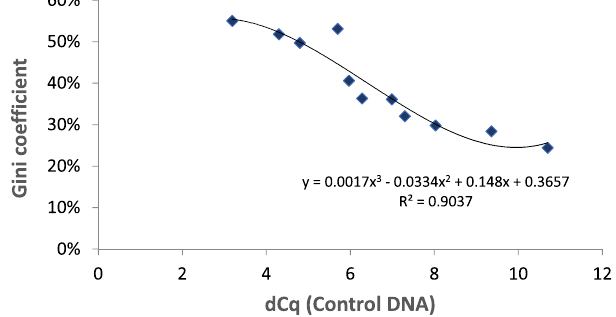
Figure 6. Correlation of dCq value of Control-DNA during coWGA and Gini coefficient. The Gini coefficient was determined from read counts mapped to 100 k bins of the human genome. While the dCq value is determined prior to NGS library formation and sequencing, the Gini coefficient is calculated after